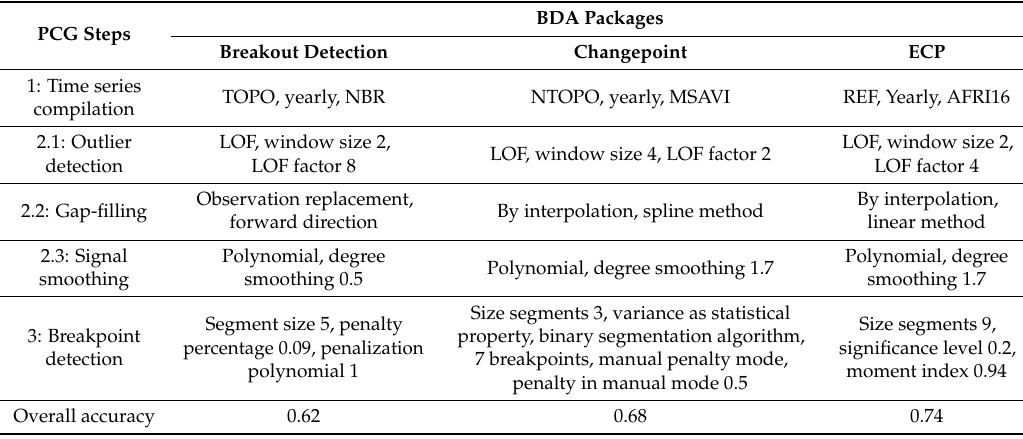
Table 4. Parameter selection by GA as best calibration solutions.